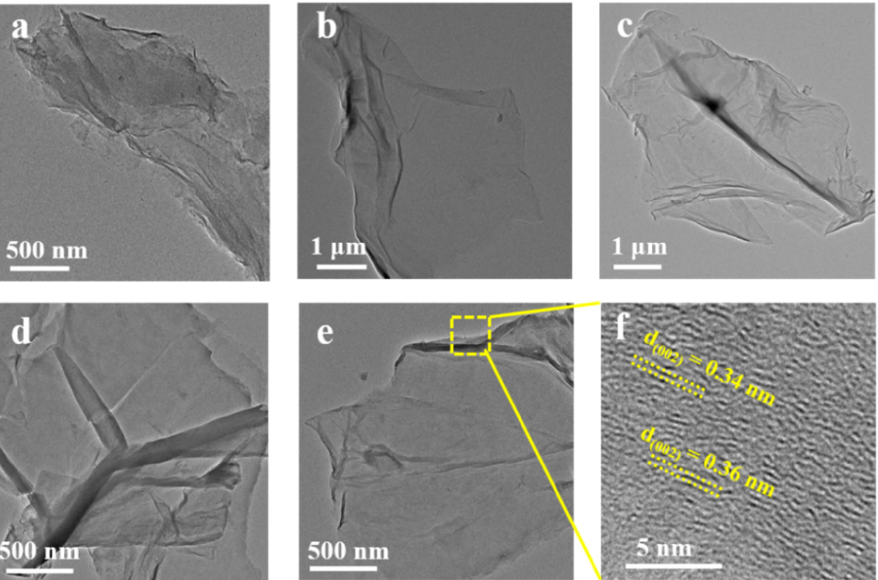
Figure 2. TEM micrographs of ( a ) GO, ( b ) RGO-RT-15, ( c ) RGO-RT-50, ( d ) RGO-RT-100, and ( e ) RGO-105-50. HRTEM micrographs of ( f ) RGO-105-50.